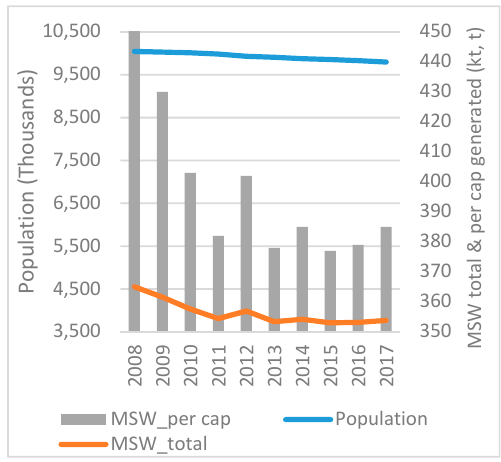
Figure 33. Population and MSW production in Hungary 2008–2017 (EUROSTAT 2019a, 2019c).